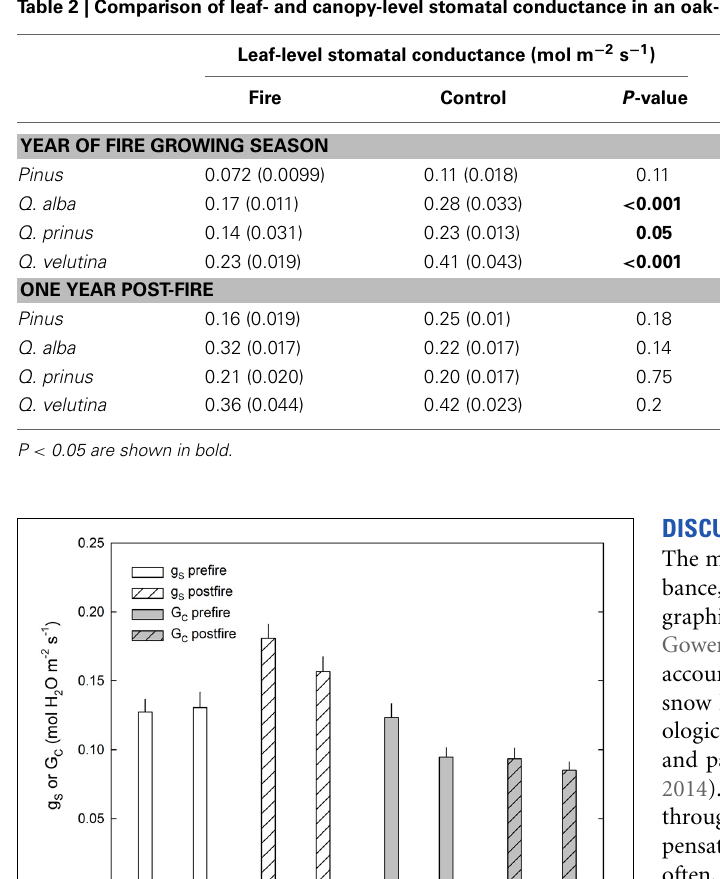
Table 2 | Comparison of leaf- and canopy-level stomatal conductance in an oak-pine forest that experienced a prescribed fire.